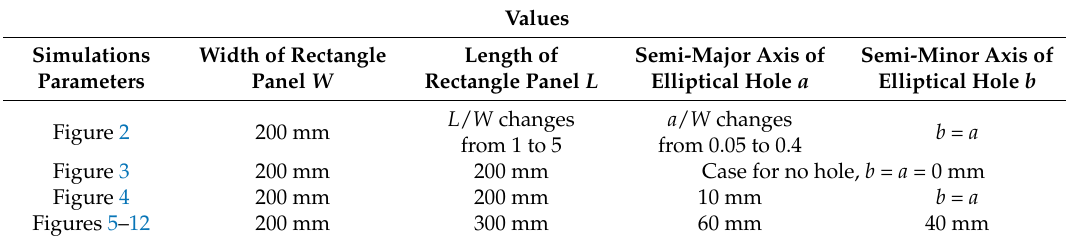
Table 1. The values of simulation parameters.